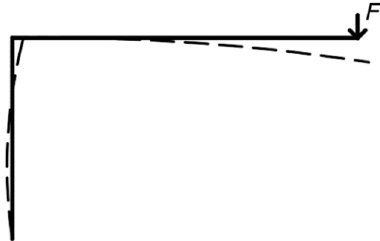
Figure 6. Deformation of segments due to bending moment and shear force.